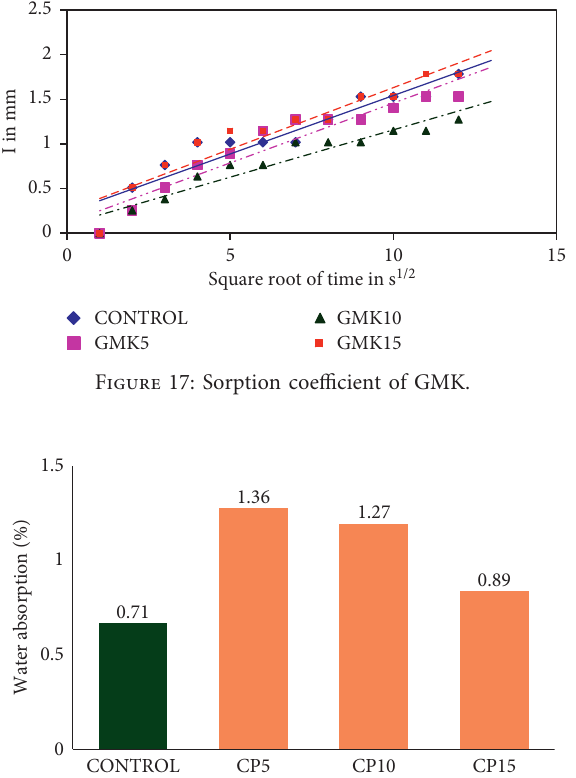
Figure 22: Porosity: SF.